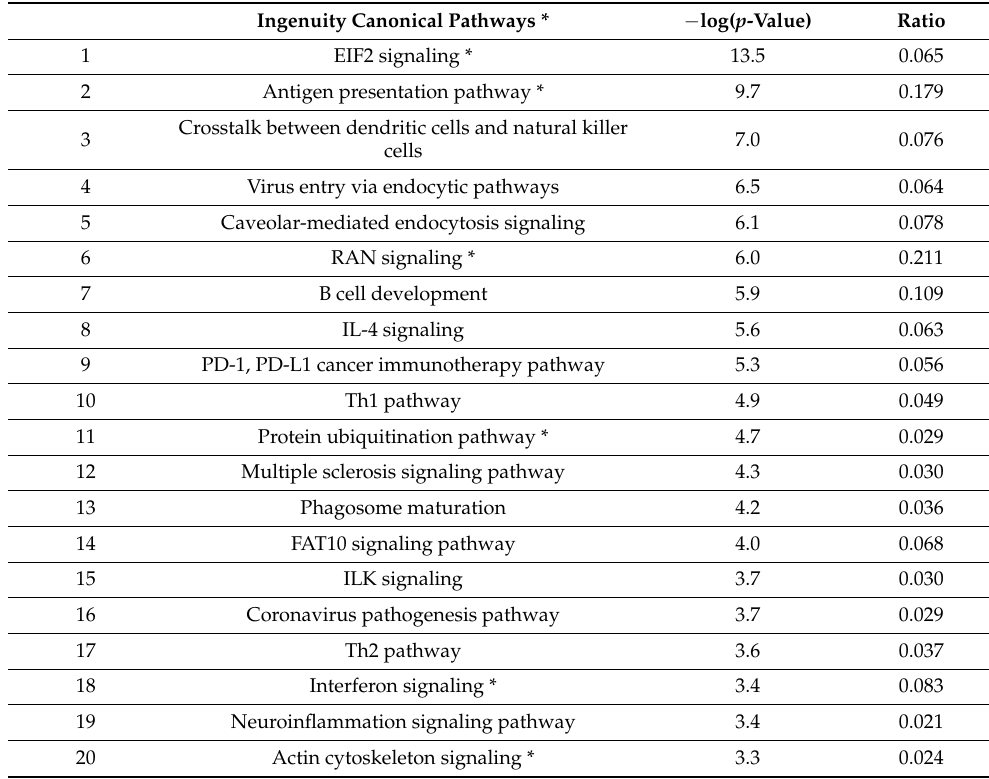
Table 2. Signaling pathways found dysregulated in our